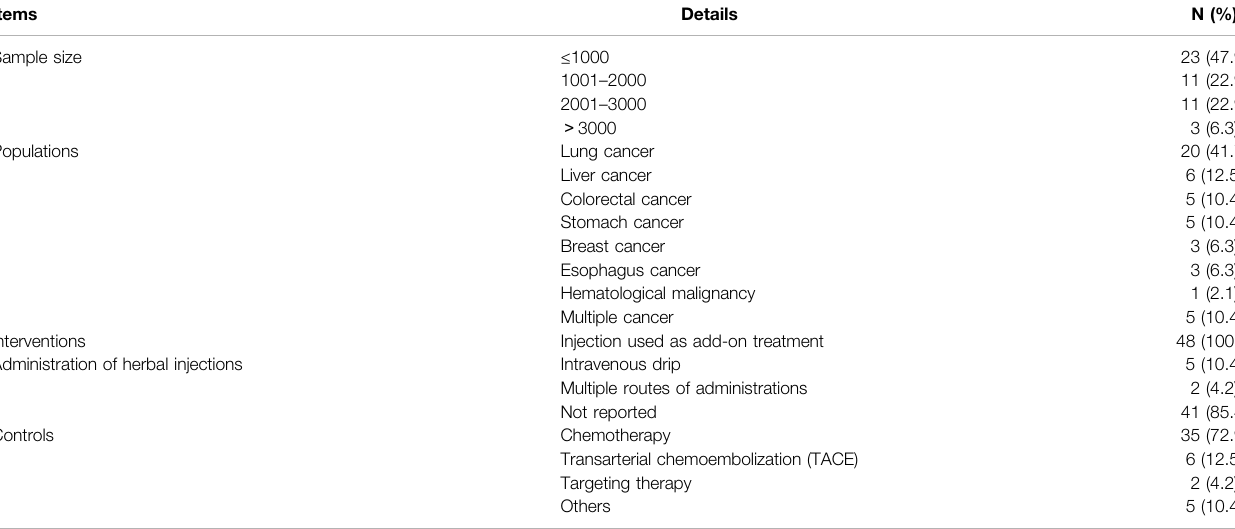
TABLE 5 | The clinical characteristics of the included systematic reviews and meta-analyses of Chinese herbal injections for cancer care.